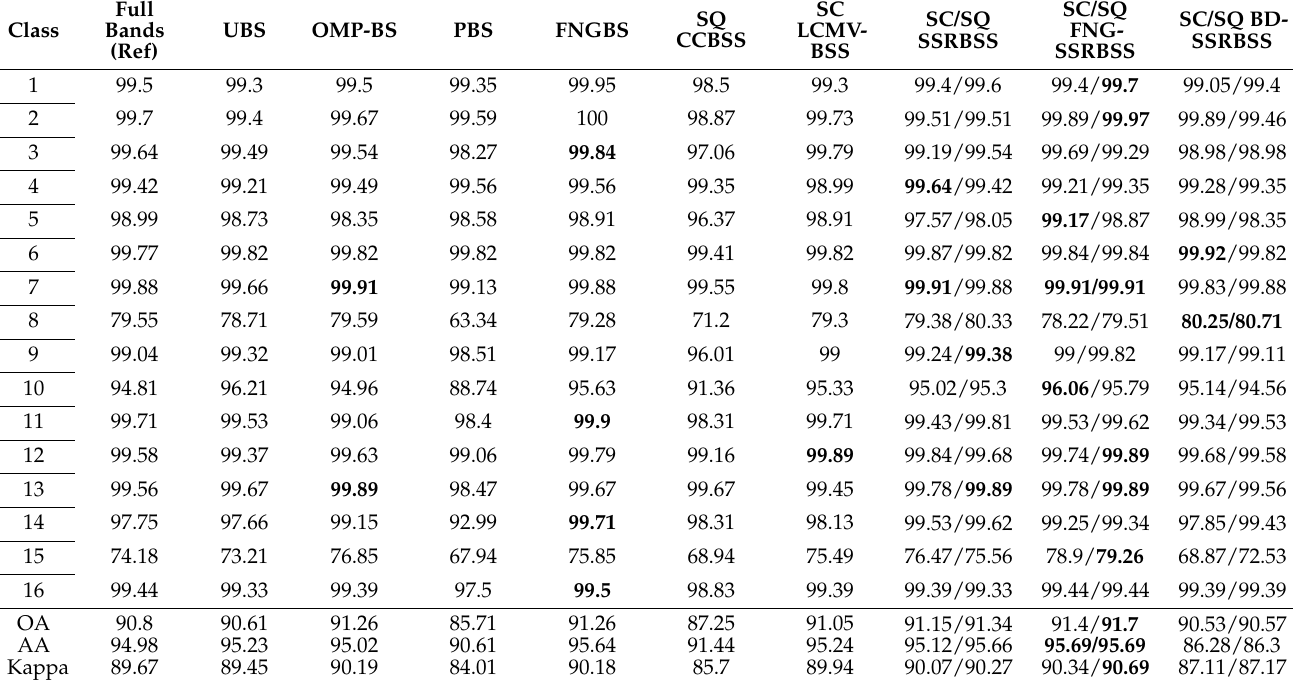
Table 8. SVM classification results of using the bands described in Table 5 for the Salinas dataset.